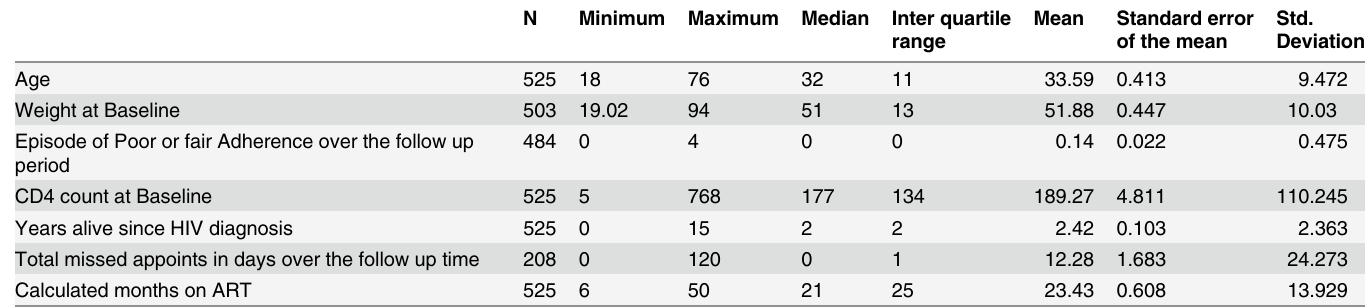
Table 2. Descriptive Statistics of characteristics of ART patients in private health facilities in Addis Ababa, 2009 – 2013.